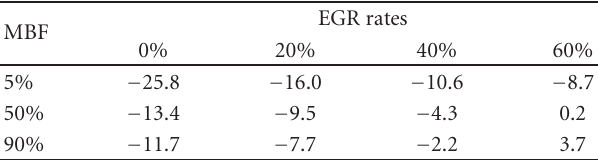
Figure 12: CH 2 O and HO 2 radical formation(1400rpm; 25% load; 17.5 CR; 0% EGR). Table 2: Location of 5%, 50%, and 90% mass burned fraction in degree CA for 0%, 20%, 40%, and 60% EGR rates.